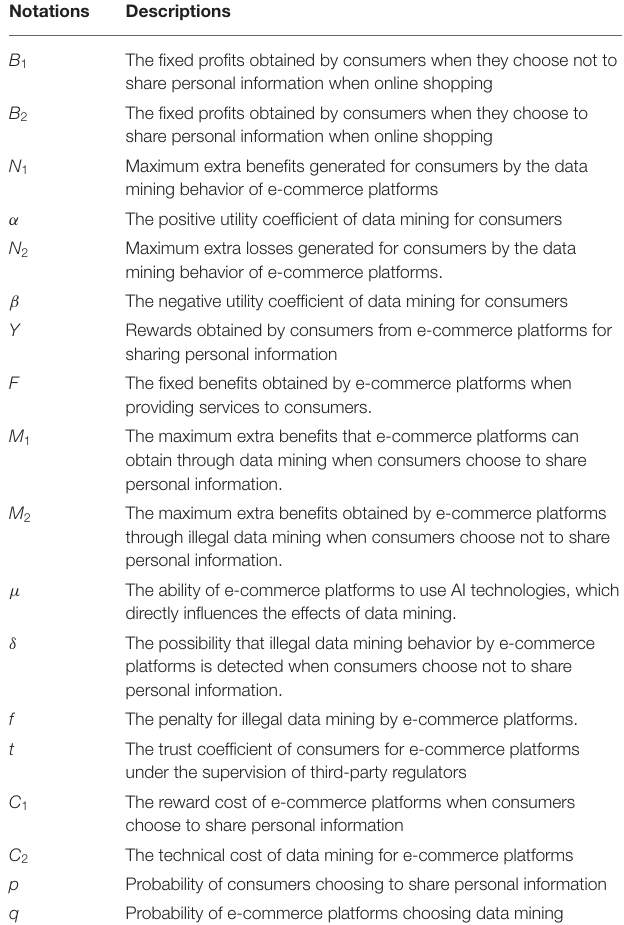
TABLE 1 | Notations for the model. TABLE 2 | Payoff matrix of consumers and e-commerce platforms in privacy